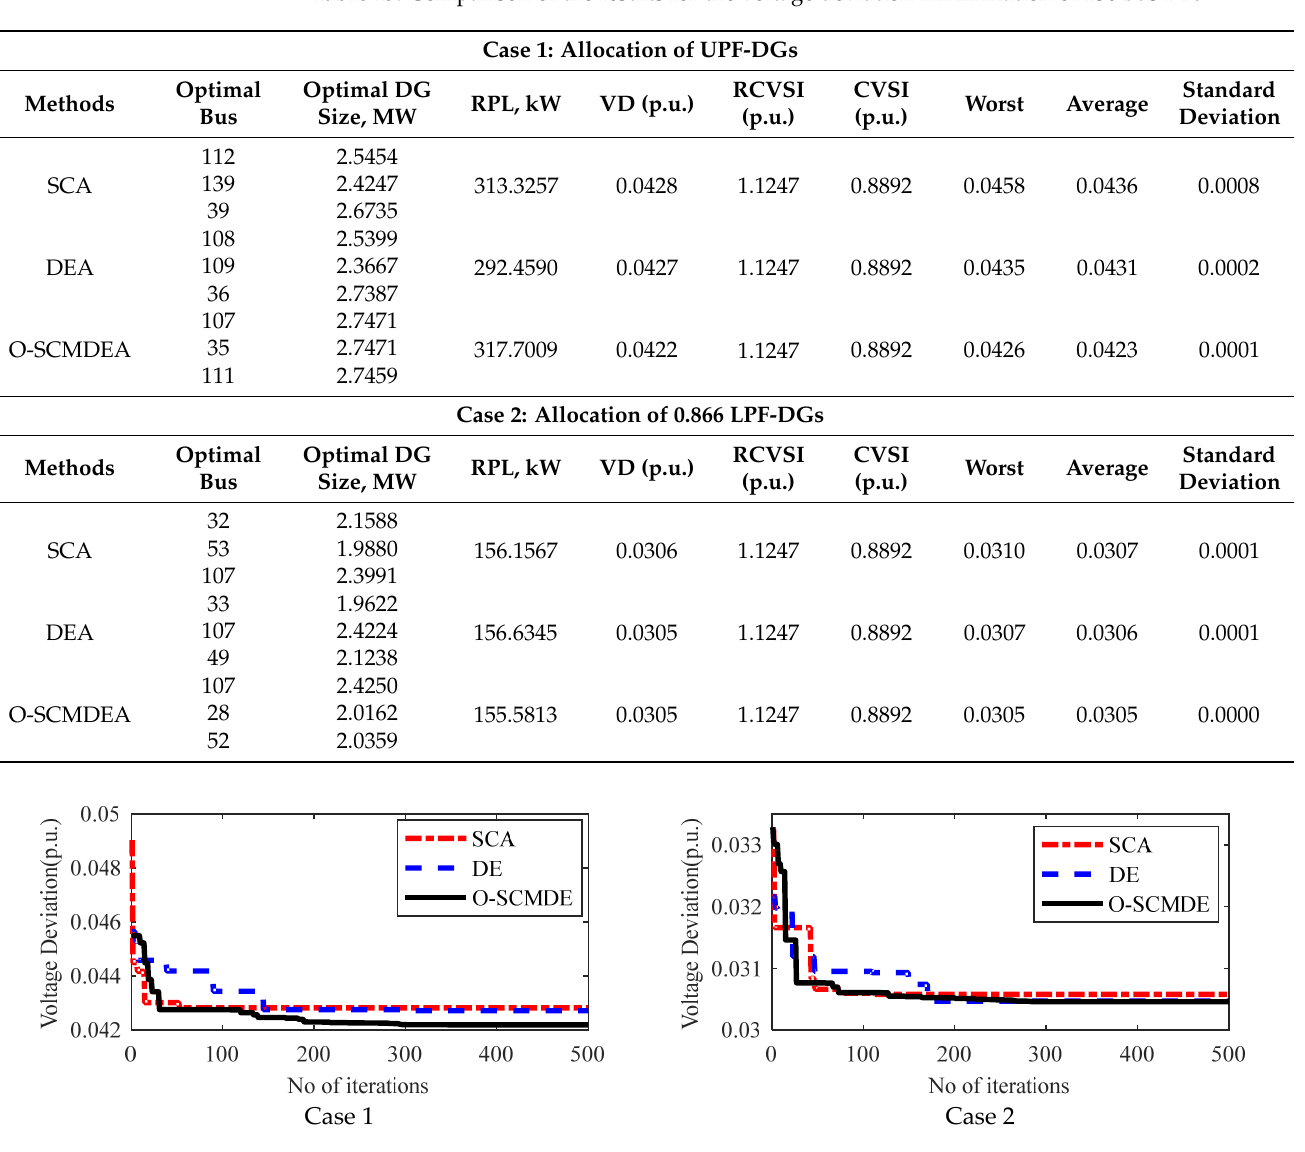
Table 13. Comparison of the results for the voltage deviation minimization of 136 bus DN.